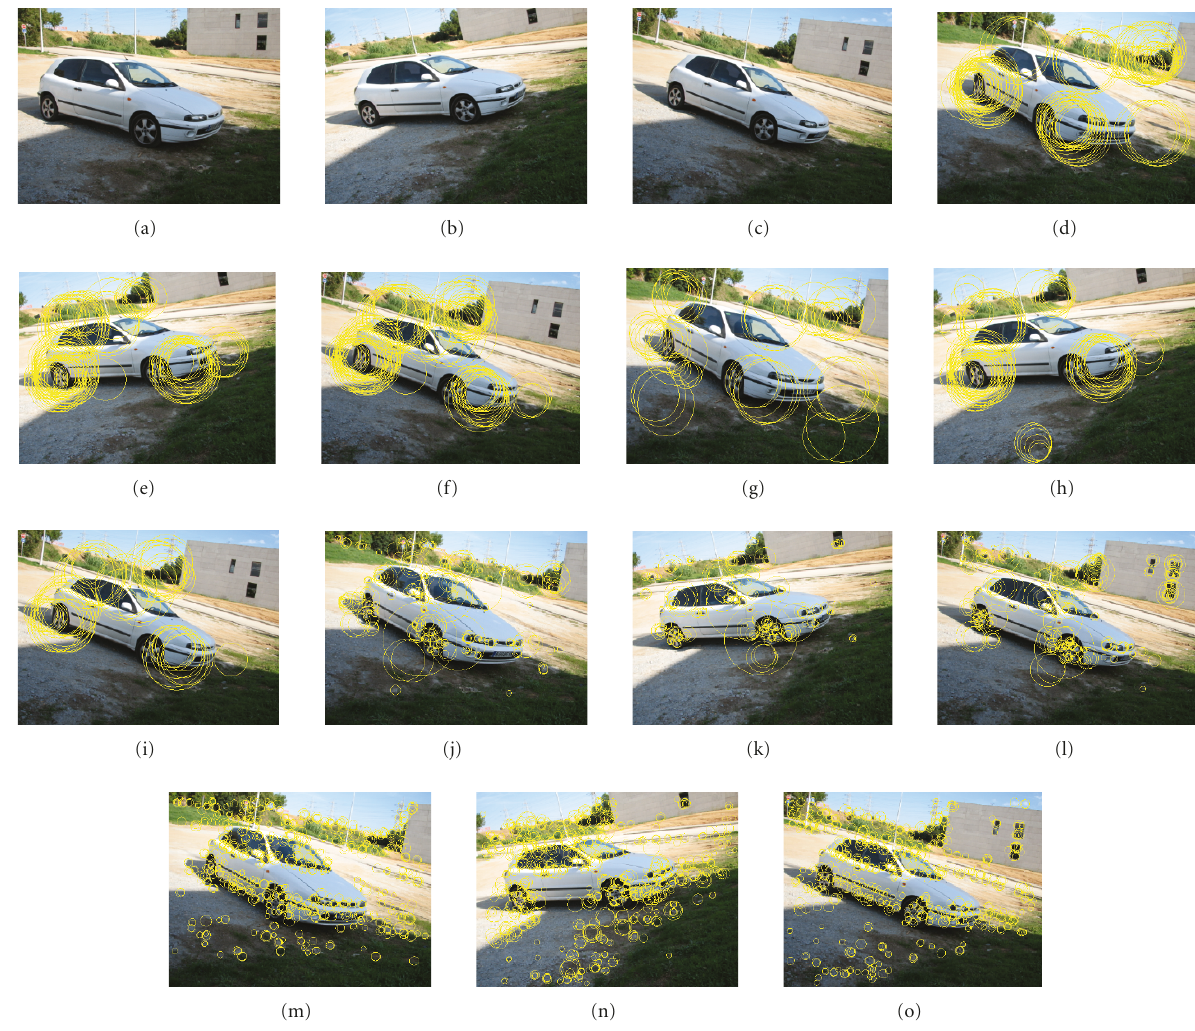
Figure 12: (a)–(c) Original images and region detection for (d)–(f) complex salient features, (g)–(i) gray-level entropy, (j)–(l) Harris- Laplacian, and (m)–(o) Hessian-Laplacian for a set of vehicle images from di ff erent camera points of